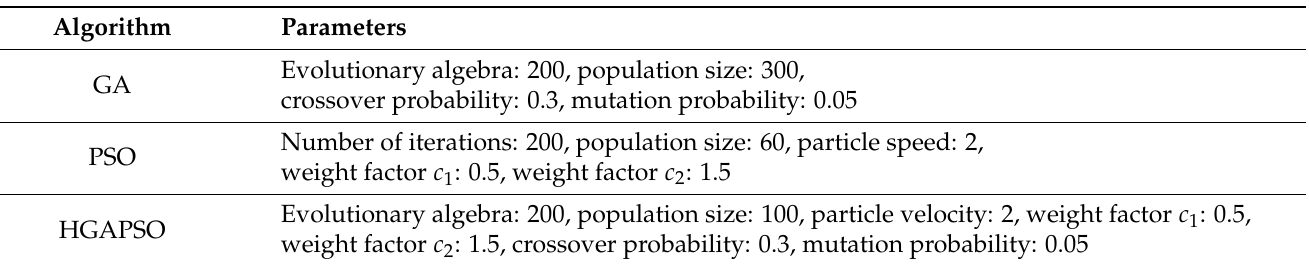
Table 4. Parameters of different algorithms.